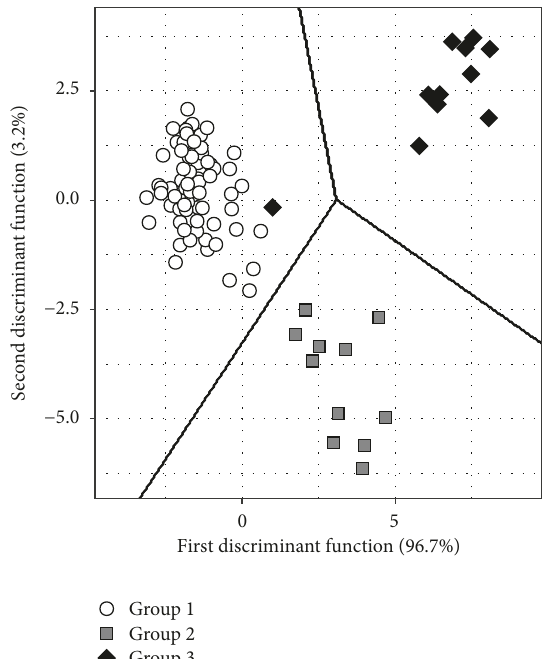
Figure 6: Classification performance (original grouped data) of the E-tongue-LDA-SA model (28 selected sensors): discrimination of olive oils according to the heat-induced cooking process (group 1: unheated olive oil plus oven heating for 15 to 60 min and microwave heating for 1.5 to 3 min; group 2: microwave heating for 5min; and group 3: microwave heating for